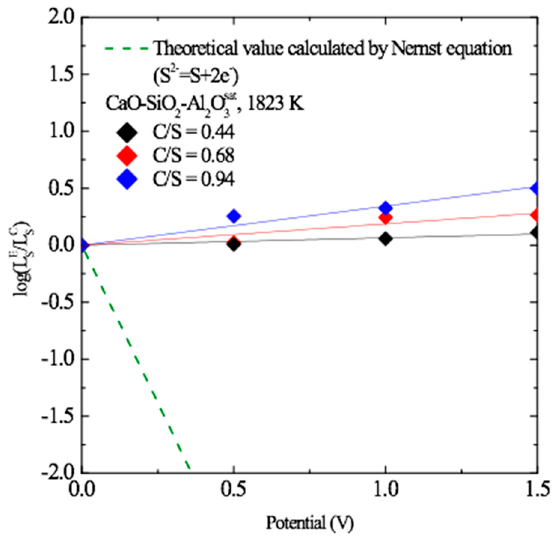
Figure 2. Sulfur partition ratio as a function of the anodic potential in the three CSA melts at 1823 K.